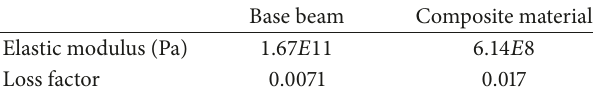
Table 5: Updated material